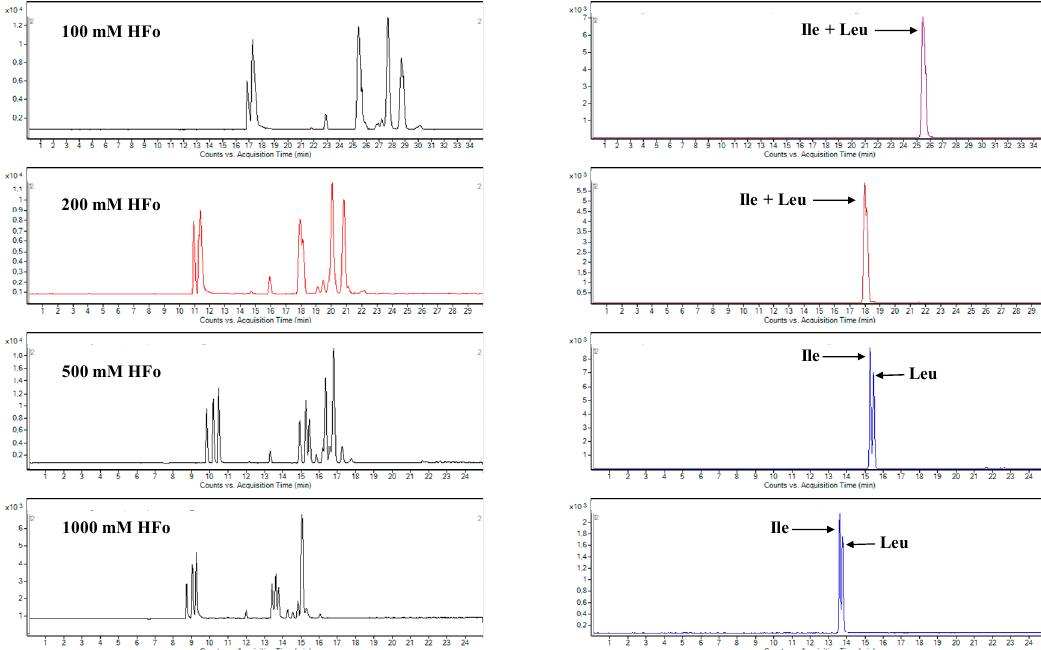
Figure 1. Effect of the concentration of formic acid in background electrolyte (BGE) on the separation selectivity of 20 proteinogenic amino acids in water solution. Left panels: total ion current (TIC) profiles. Right panels: extracted multiple reaction monitoring (MRM) records of two isomeric amino acids (isoleucine and leucine) obtained under the same conditions as TIC. For details of the capillary electrophoresis-tandem mass spectrometry (CE-MS/MS) method see Section 3.